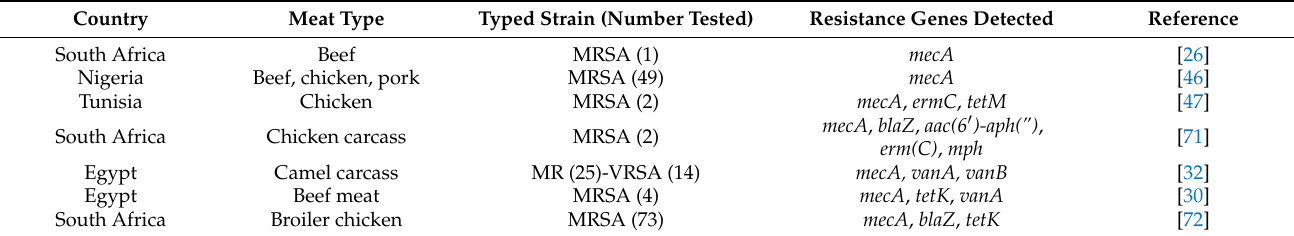
Table 10. Antimicrobial resistance genes of MRSA from African